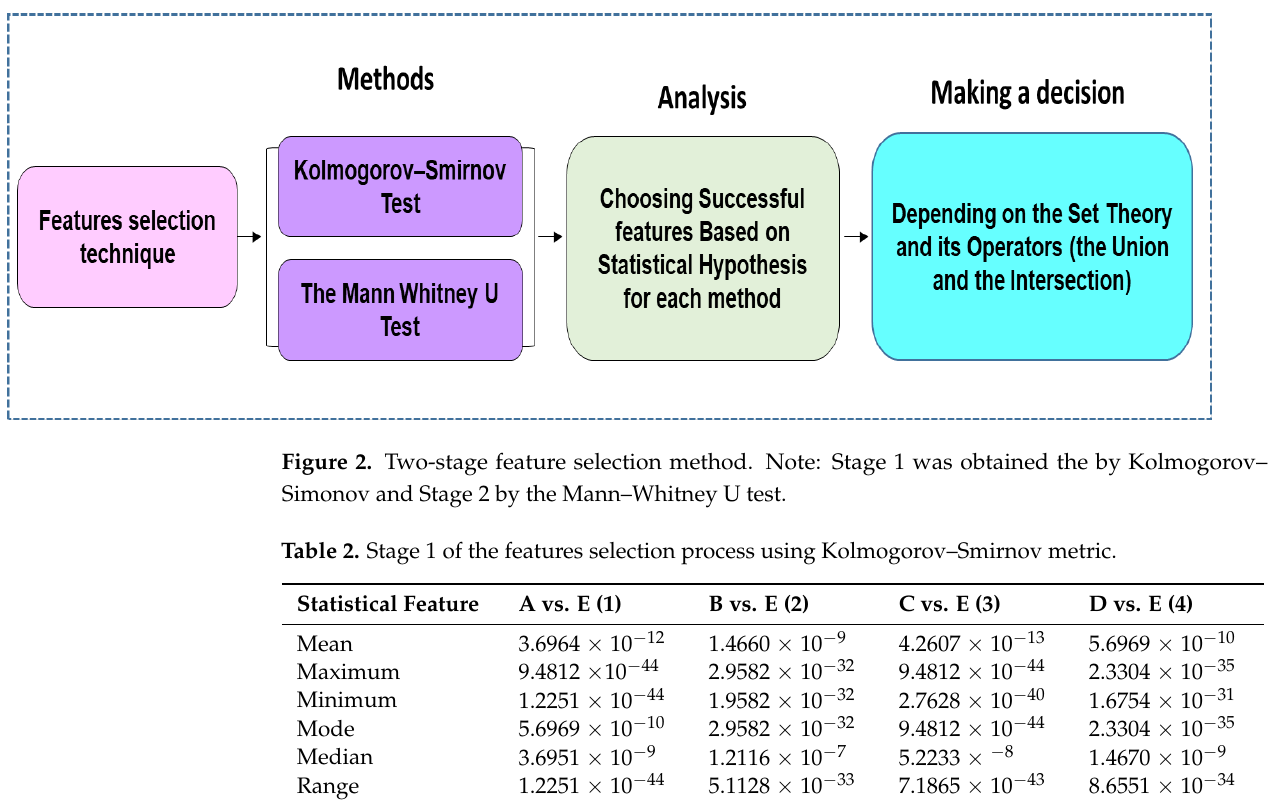
Table 2. Stage 1 of the features selection process using Kolmogorov – Smirnov metric.